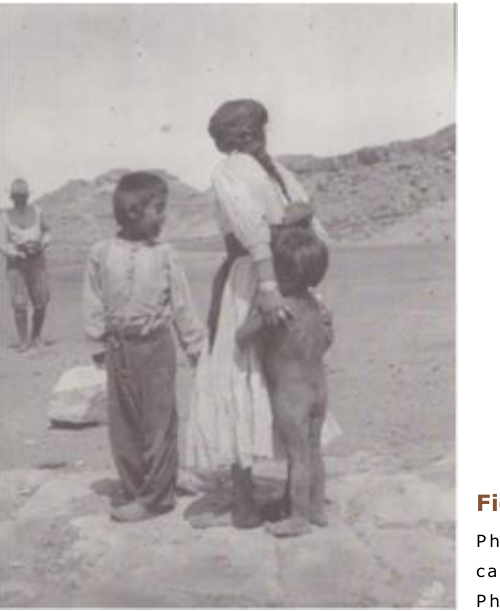
Photographer unknown, Navajo Children